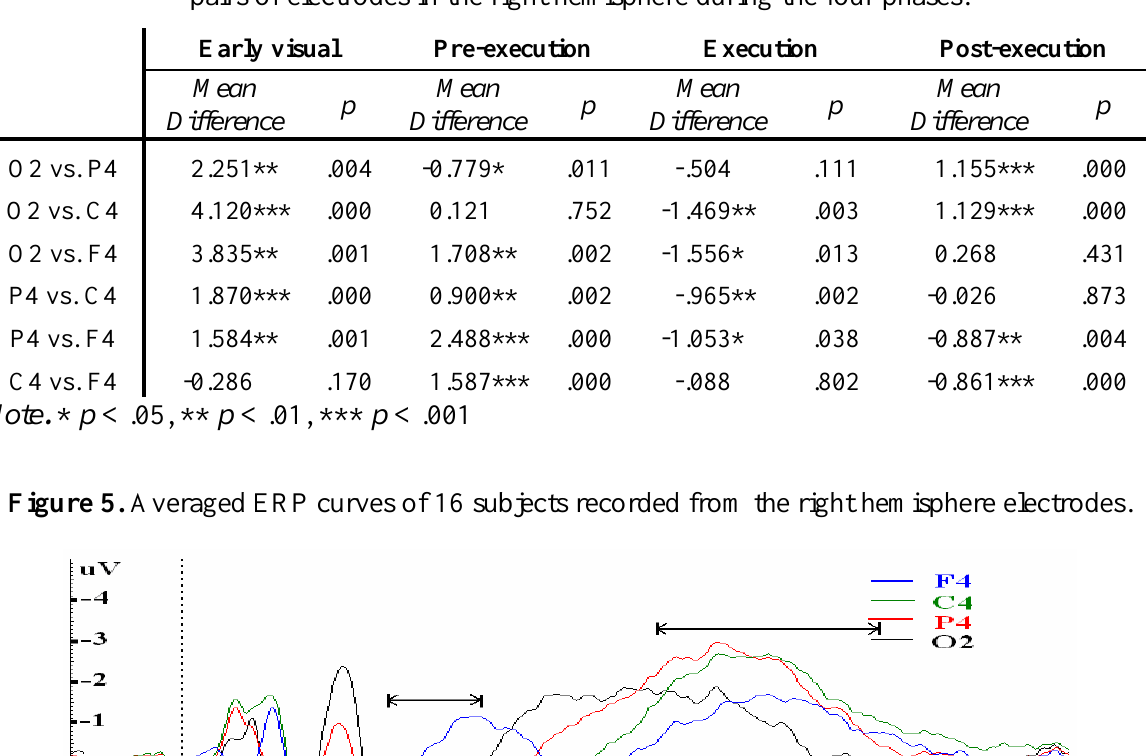
Table 4. LSD post hoc tests to compare the differences of mean amplitudes between the pairs of electrodes in the right hemisphere during the four phases.